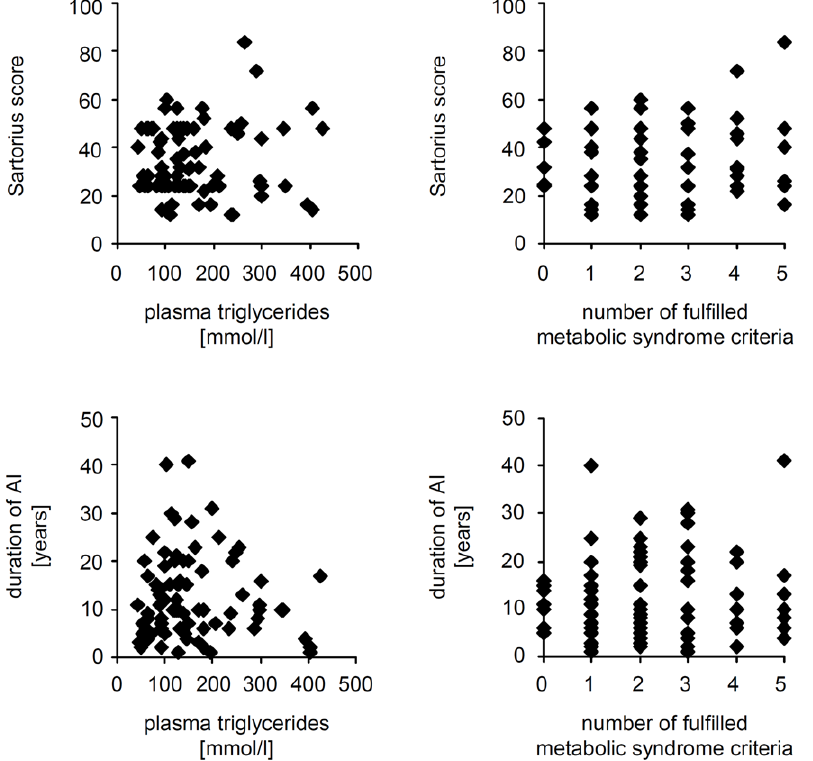
Figure 4. Correlation of disease severity and duration with parameters of the metabolic syndrome for AI patients. The correlation of Sartorius scores and duration of AI with each plasma TG levels and the number of positive metabolic syndrome criteria was investigated by Spearman’s rank correlation analysis. No significant correlation was found. doi:10.1371/journal.pone.0031810.g004 PLoS ONE |